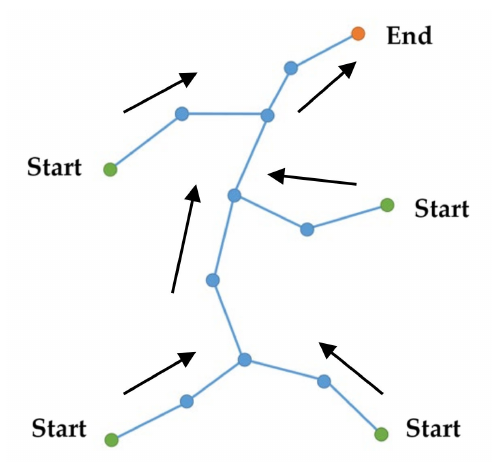
Figure 3. A priori paths with different start